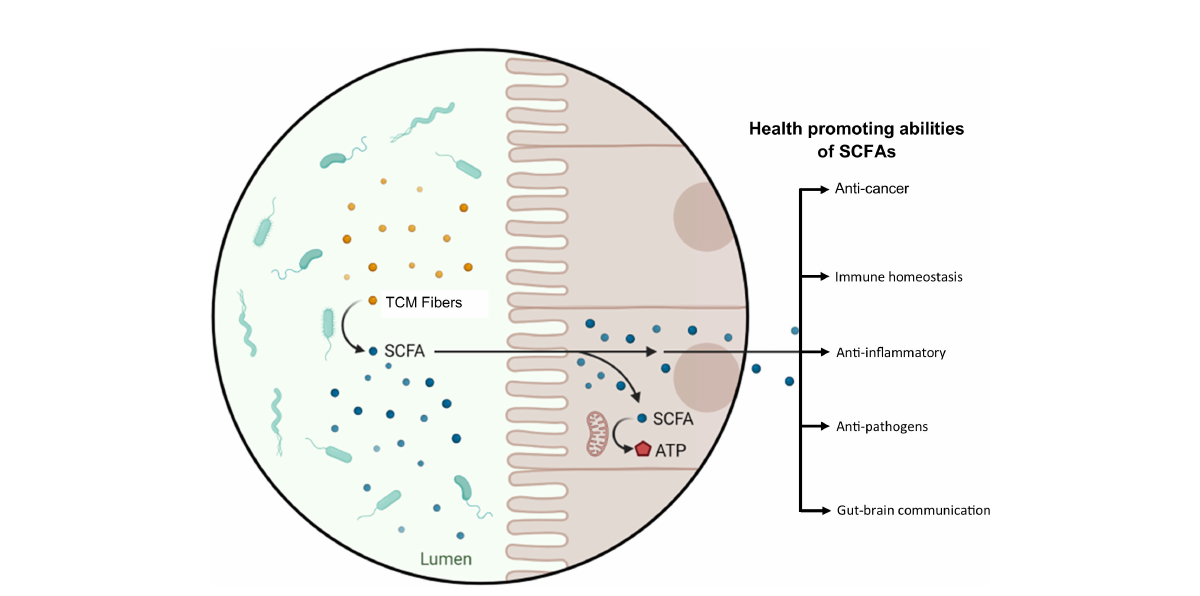
FIGURE 1 TCM – GM combinatorial therapeutic effect, taking polysaccharides as an example. Dietary and medicinal fi bers are converted into SCFAs by the action of the GM. SCFAs are an energy source for colonocytes and possess other health-promoting abilities; a few of these abilities are displayed in the fi